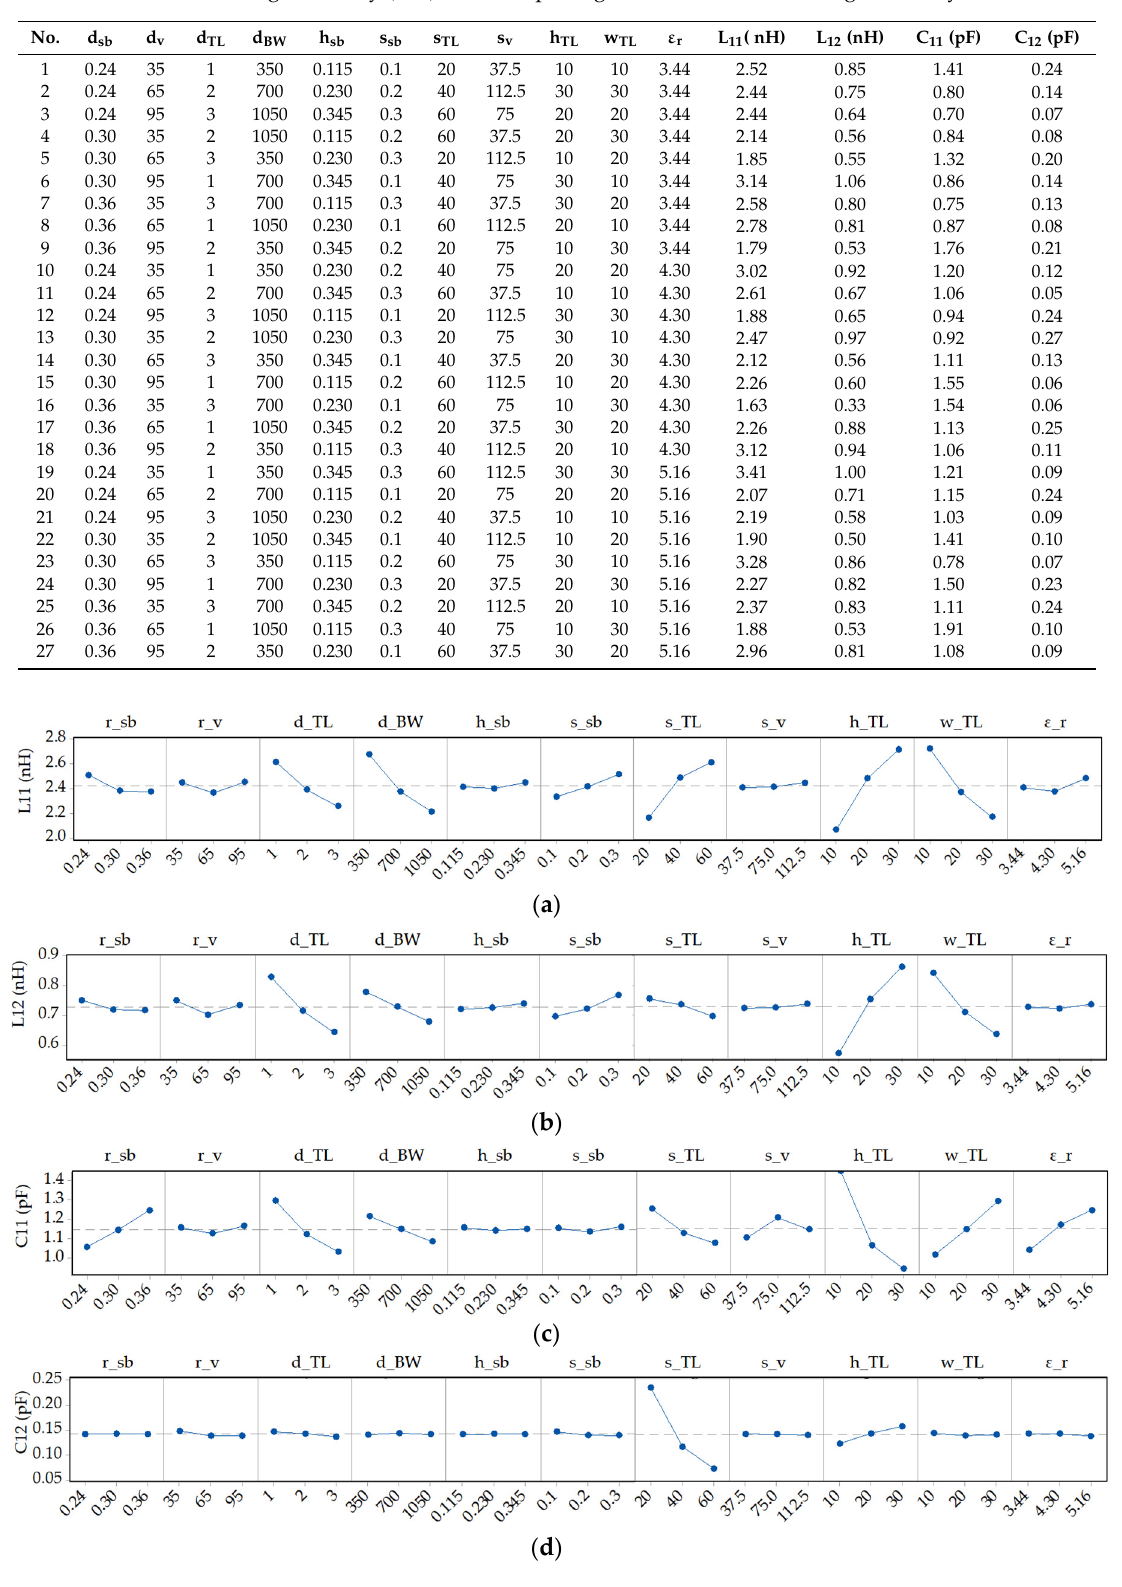
Figure 7. Design of experiments (DoE) results obtained using the Taguchi method for ( a ) L 11 , ( b ) L 12 , ( c ) C 11 , and ( d ) C 12.